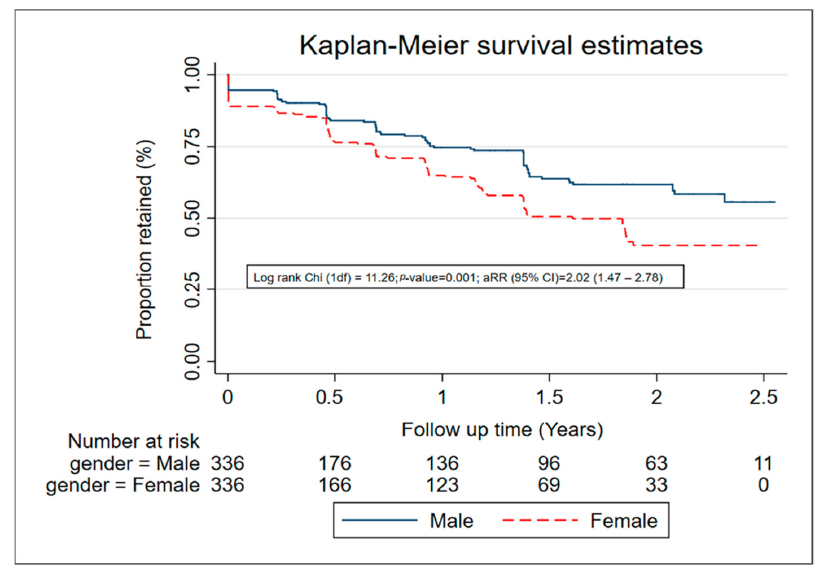
Figure 1. Retention among 672 participants in an HIV vaccine-preparedness cohort, Masaka, Uganda (July 2018–March 2021).